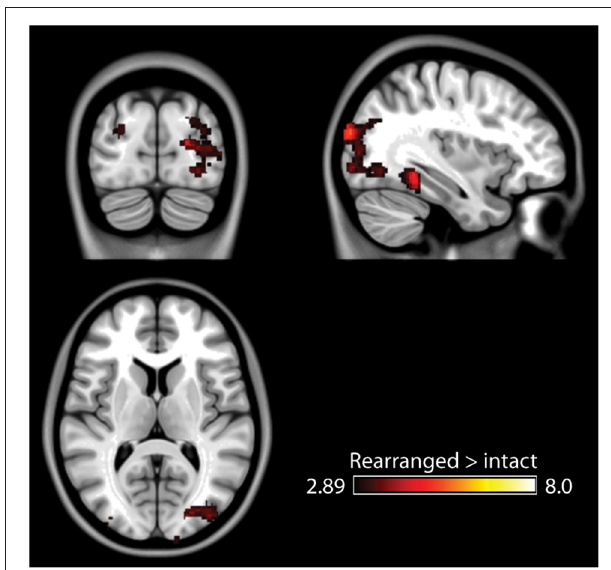
FIGURE 4 | Results of the associative memory contrast at a more lenient threshold ( p < 0.005 uncorrected) . Posterior activity remains spatially constrained relative to the stimulus and semantic novelty